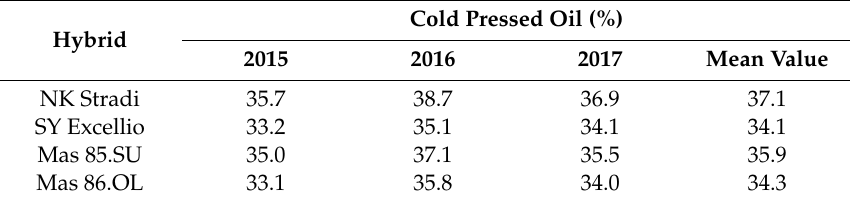
Table 6. Results of the mechanical extraction tests.